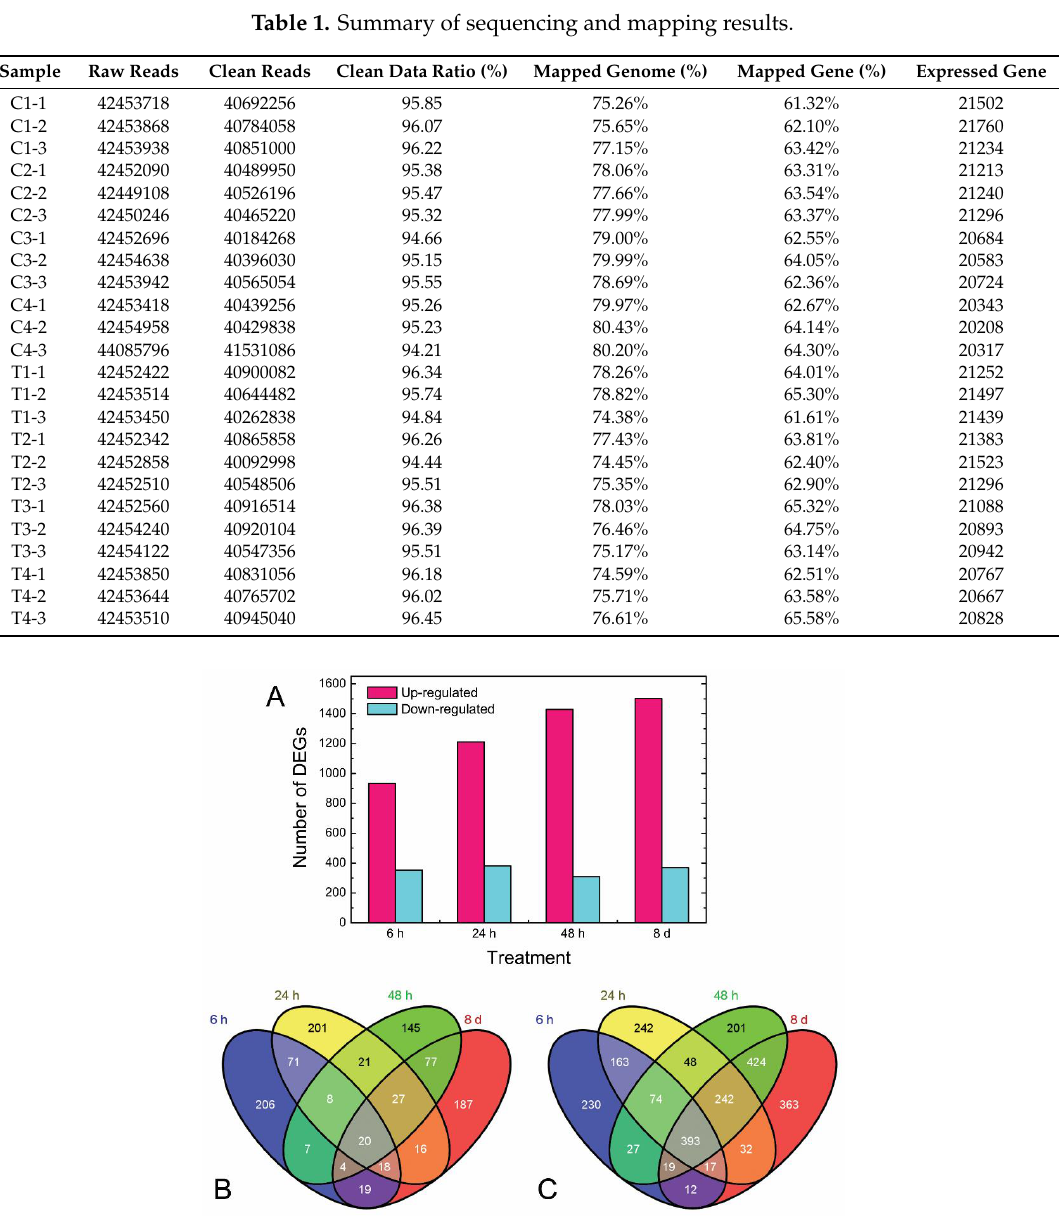
Figure 2. Comparative analysis of differentially expressed genes (DEGs) at 6 h, 24 h, 48 h, and 8 d. ( A ): Number of DEGs from samples with light exposure compared with that in dark at the same time point. ( B , C ): Venn diagram summarizing the down-regulated ( B ) and up-regulated ( C ) DEGs detected among four time points (6 h, 24 h, 48 h, and 8 d). Common and specific genes to each time point treatment are represented in the photograph.